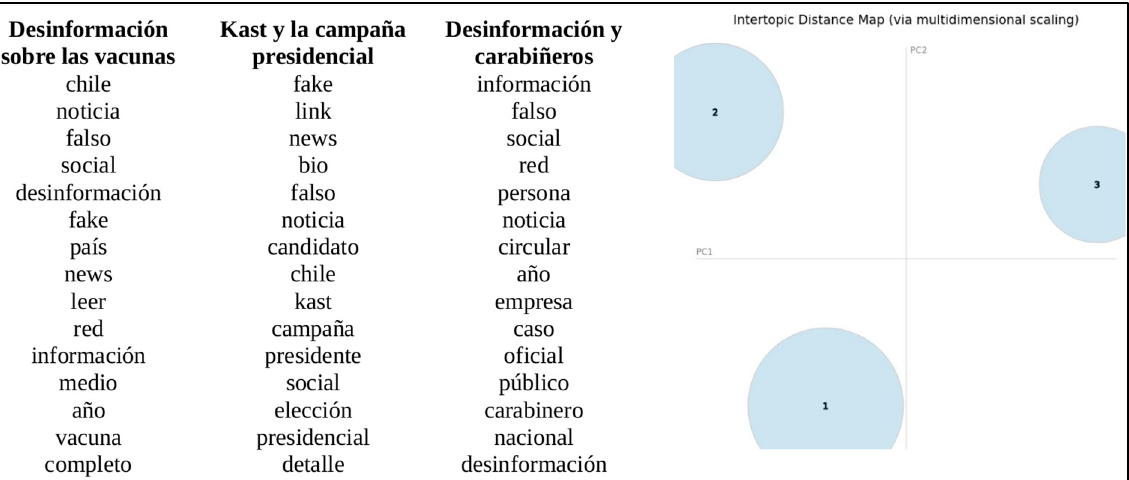
Figure 5. Top words and projection in the main foreground of the three topics obtained with